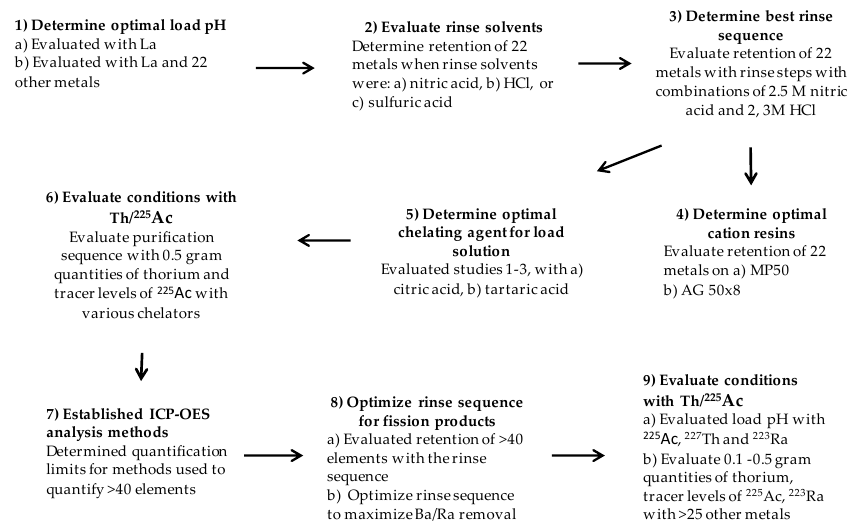
Figure 1. Flow chart illustrating the sequence of studies reported in the manuscript.